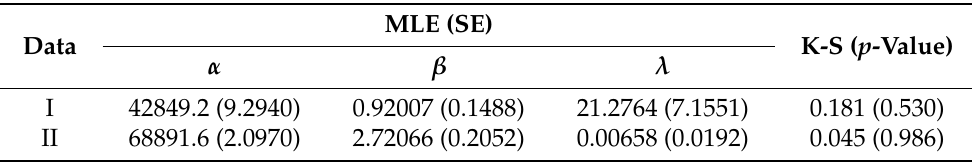
Table 3. Summary fit of the APW distribution under real data